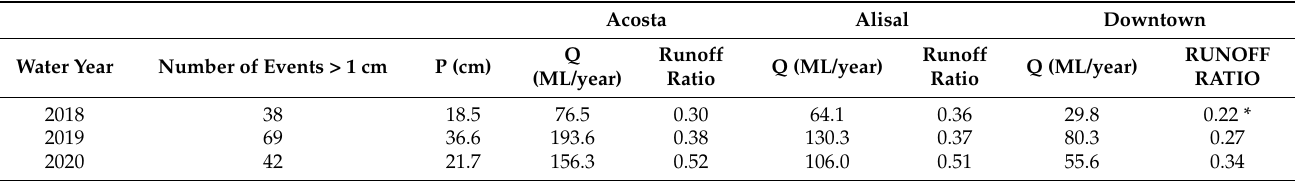
Table 2. Outfall monitoring results’ summary for each water